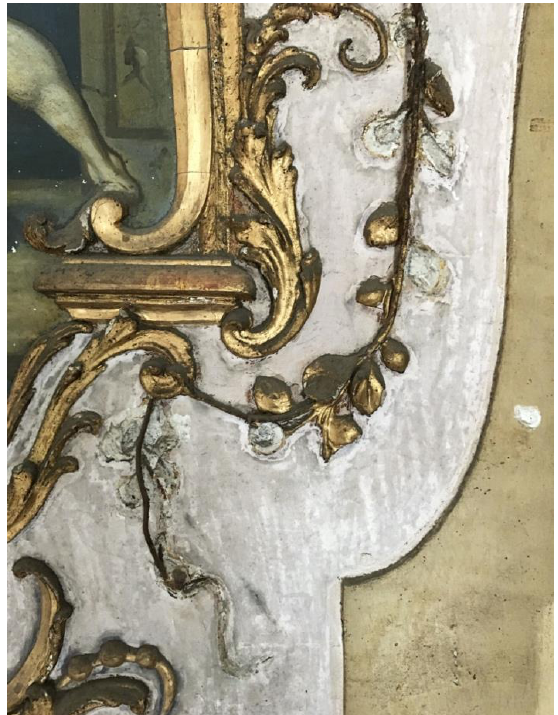
Figure 11. Wall 2: detail of the iron wires resembling stems from which leaves and blossoms hang.